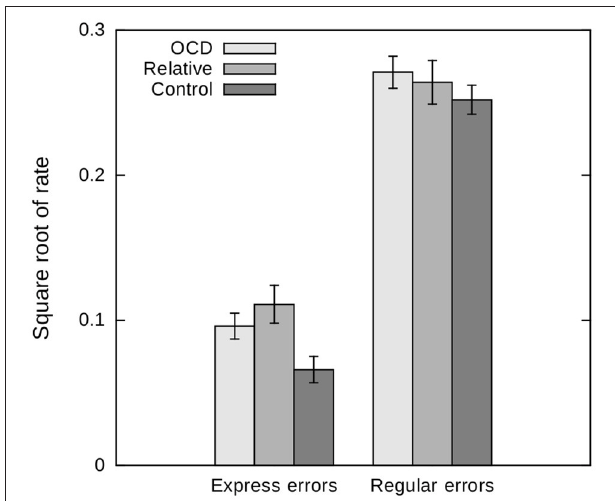
FIGURE 3 | Express and regular error rates in the antisaccade task in patients with obsessive-compulsive disorder (OCD), unaffected first-degree relatives and healthy control subjects. Age is included as a covariate and values are depicted for a mean age of 36.37 years. Error bars indicate standard errors. Groups differ significantly regarding express errors ( p = 0.007), but not regarding regular errors ( p = 0.45).